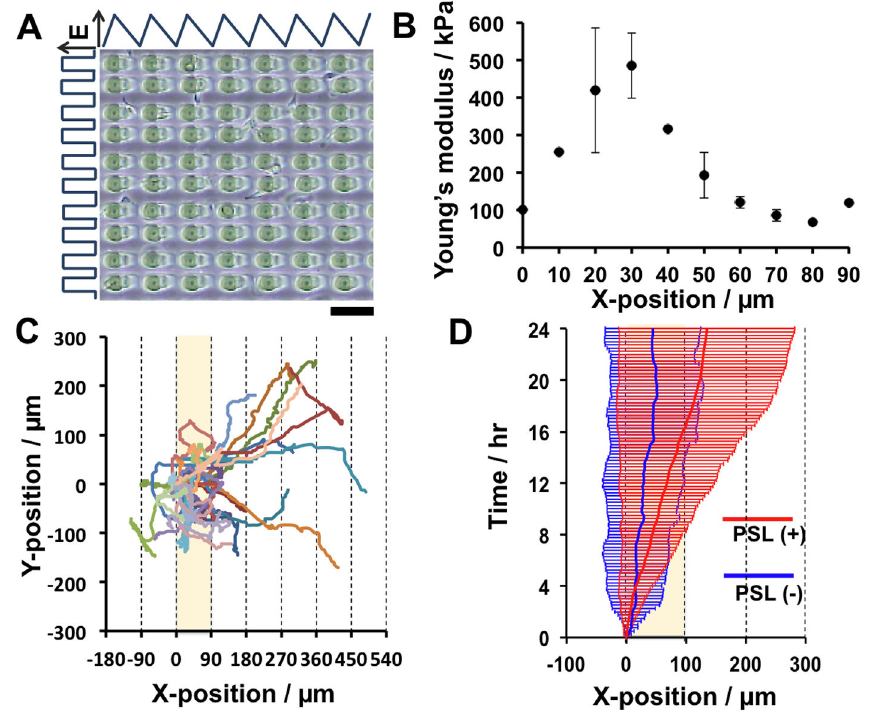
Figure 7. Long-range cell migration on gels with saw-like asymmetric elasticity patterns and perpendicular soft lanes (PSLs). The conditions used to prepare the gels are described in Table 1. (a) Phase contrast microscopy image of the gel. Sale bar: 100 µm. (b) Distribution of Young’s modulus in a single unit of the gel. Unit size: 90 µm. Elasticity peak: ca. 500 kPa. (c) Trajectories of 3T3 fibroblasts cultured on gels with PSLs. Cells were observed by time-lapse microscopy for 24 hr and images were acquired at 15 min intervals. (d) Time-course of ensemble averaged trajectories with standard deviation in the presence (red) and absence (blue) of PSLs. n=30 cells.